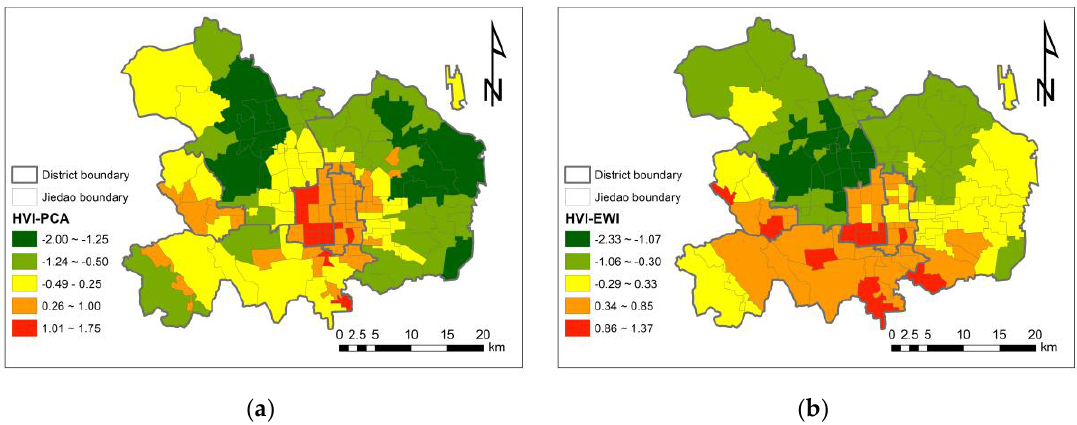
Figure 2. Spatial pattern of heat vulnerability in Beijing assessed by principal component analysis (PCA) approach ( a ) and equal-weighted index (EWI) approach ( b ).